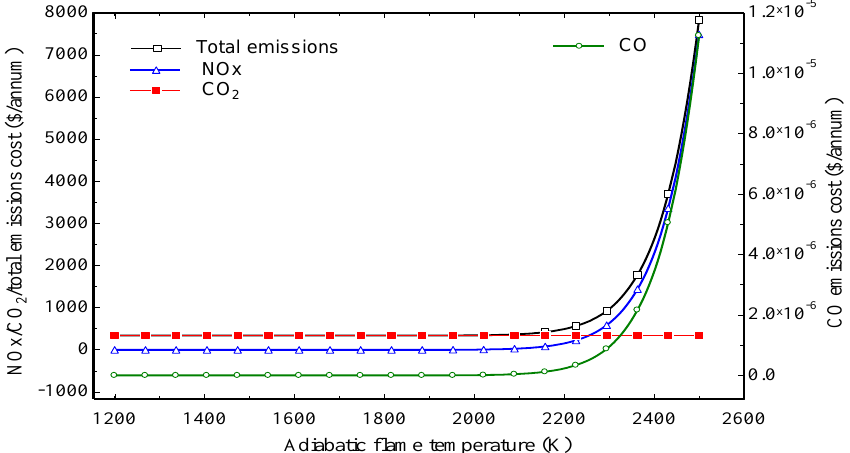
Figure 8. E ff ect of adiabatic flame temperature on cost of Figure 8. Effect of adiabatic flame temperature on cost of emissions.